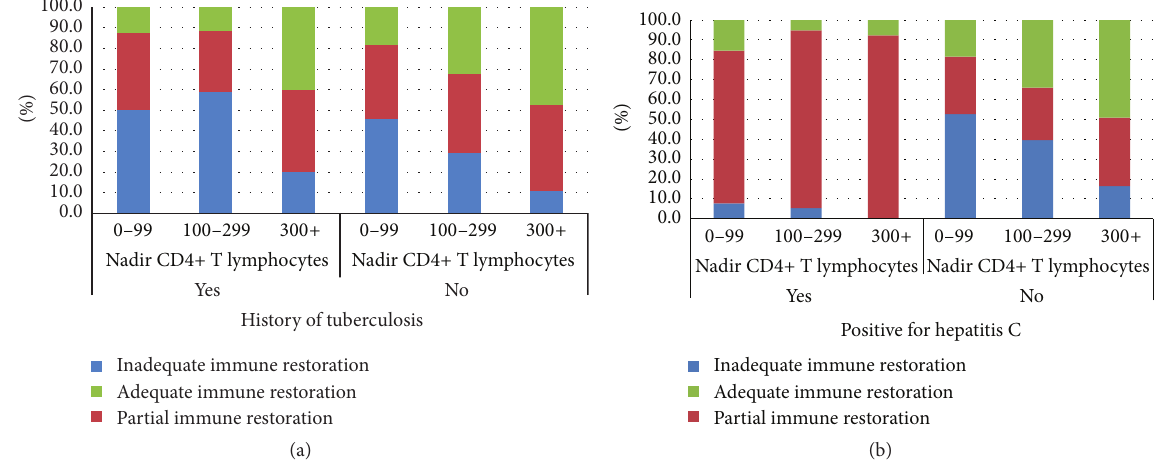
Figure 2: Distribution of patients by immune restoration patterns according to mean nadir CD4 cells and past diagnosis of tuberculosis (a) or HCV infection (b).